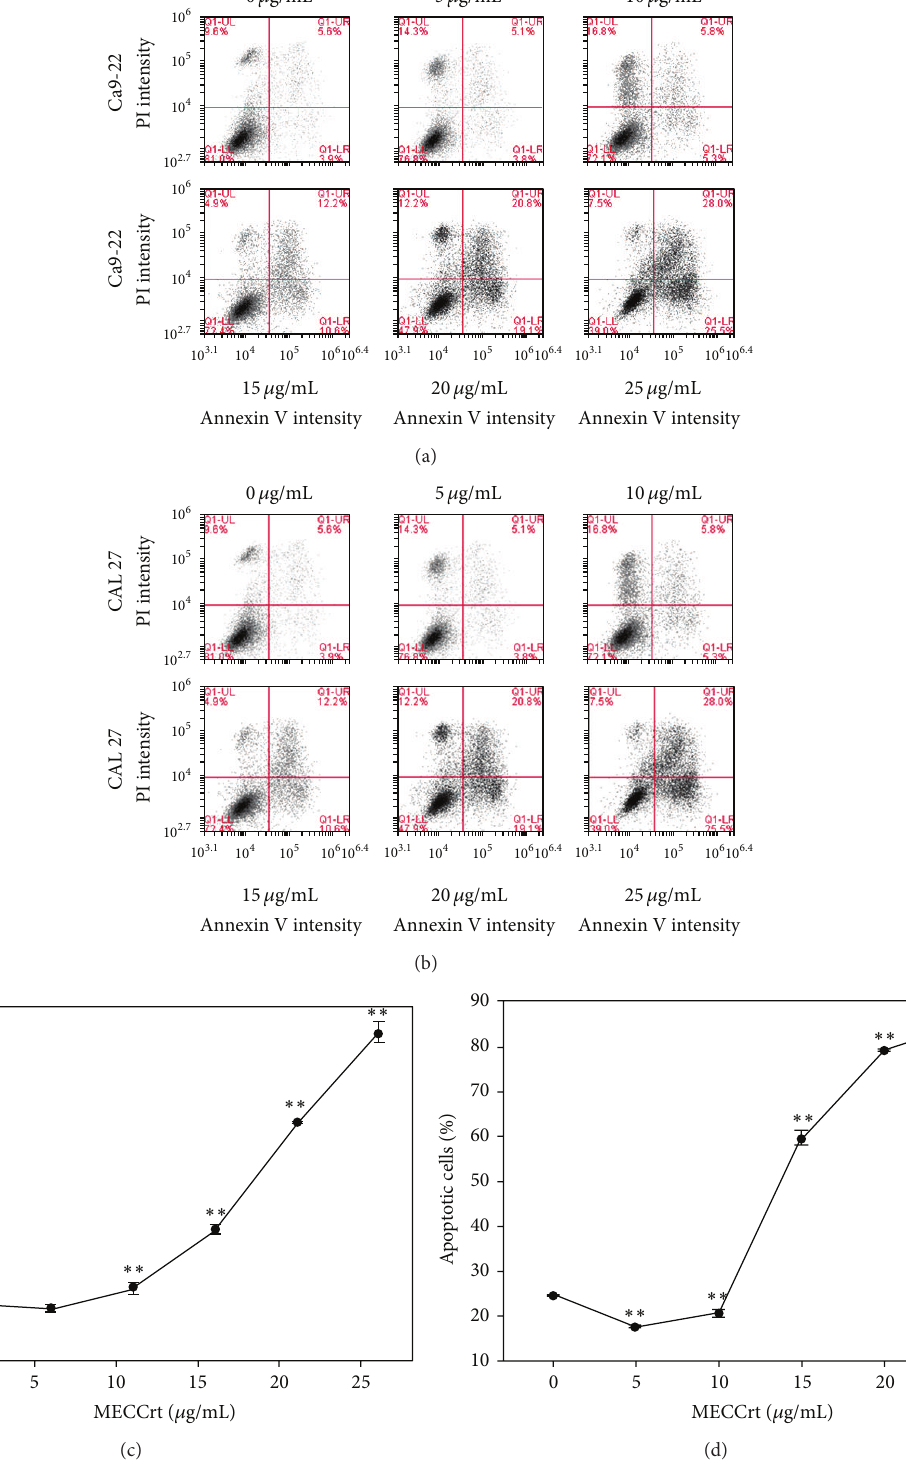
Figure 3: Apoptosis of two oral cancer cells was induced by MECCrt. Oral cancer Ca9-22 and CAL 27 cell lines were treated with 0–25 𝜇 g/mL of MECCrt for 24 h. ((a) and (b)) Representative results of annexin V/PI double staining of flow cytometry for MECCrt-treated oral cancer Ca9-22 and CAL 27 cell lines and vehicle controls at 24 h, respectively. ((c) and (d)) Quantification analysis of apoptosis for MECCrt-treated oral cancer Ca9-22 and CAL 27 cell lines in (a) and (b), respectively. Data, means ± SDs ( 𝑛 = 3 ). ∗∗ 𝑃 < 0.01 against